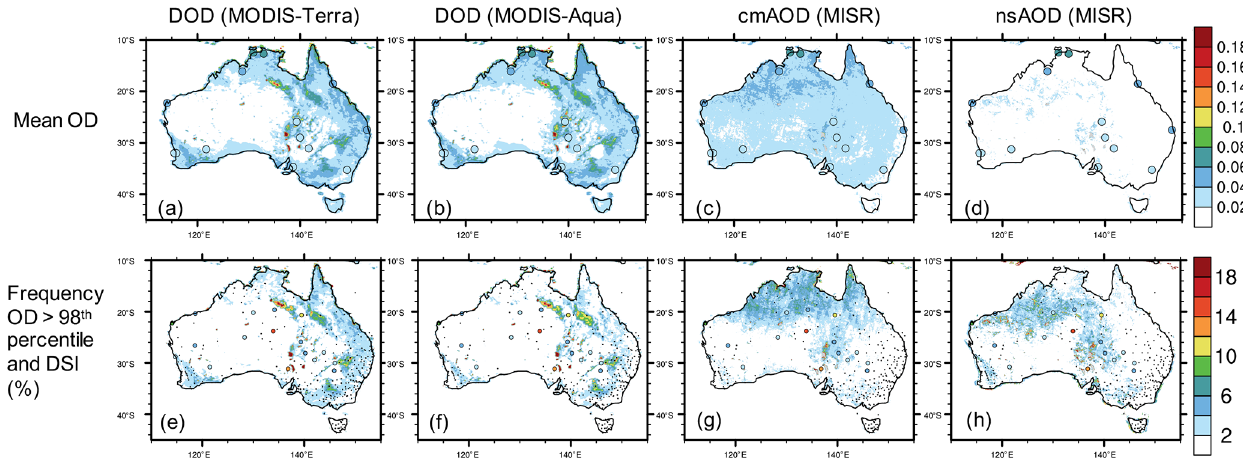
Figure 2. Annual mean dust activity over Australia during 2000–2019. In (a–d) , the map represents average DOD from (a) MODIS-Terra and (b) MODIS-Aqua and (c) coarse-mode AOD (cmAOD) and (d) non-sphere AOD (nsAOD) from MISR. Filled circles represent cmAOD from 15 AERONET sites, which are identical in (a–d) . In (e–h) , the map represents frequency of DOD proxies exceeding the 98th percentile of all observations from each instrument, namely 0.205 for DOD from MODIS-Terra, 0.198 for DOD from MODIS-Aqua, 0.095 for cmAOD from MISR, and 0.062 for nsAOD from MISR. Filled circles represent the Dust Storm Index (DSI, %) at 1489 weather stations, which is identical in (e–h) . Dots in (e–h) represent stations with annual mean DSI smaller than 2%. Grey indicates pixels with satellite sampling less than 10d during the analyzed 20